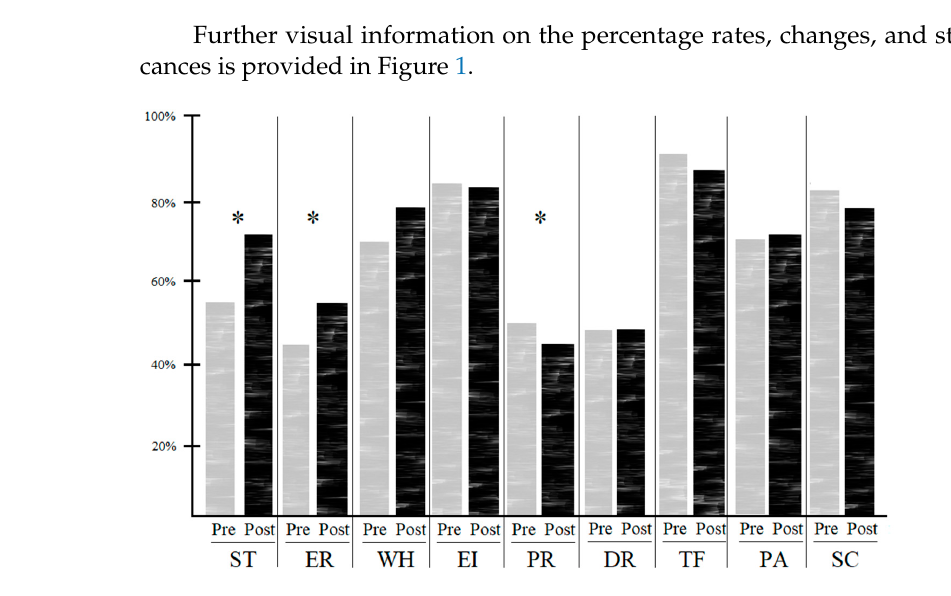
Figure 1. Comparison of average positive response rates per dimension of the APSQ-III (pre